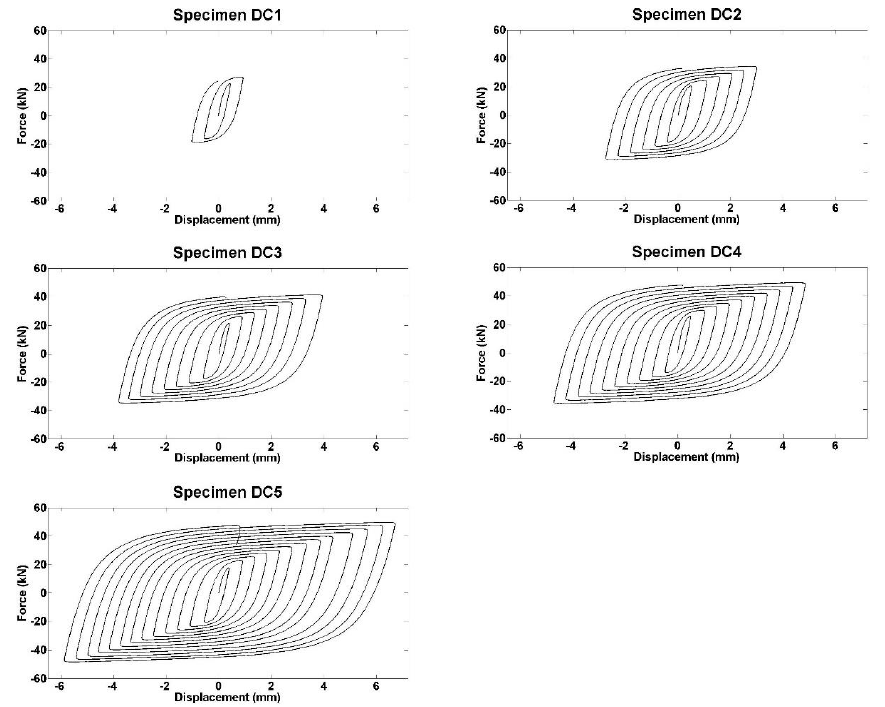
Figure 12. Typical hysteresis curves obtained from the tests of specimens DC1 to DC5.